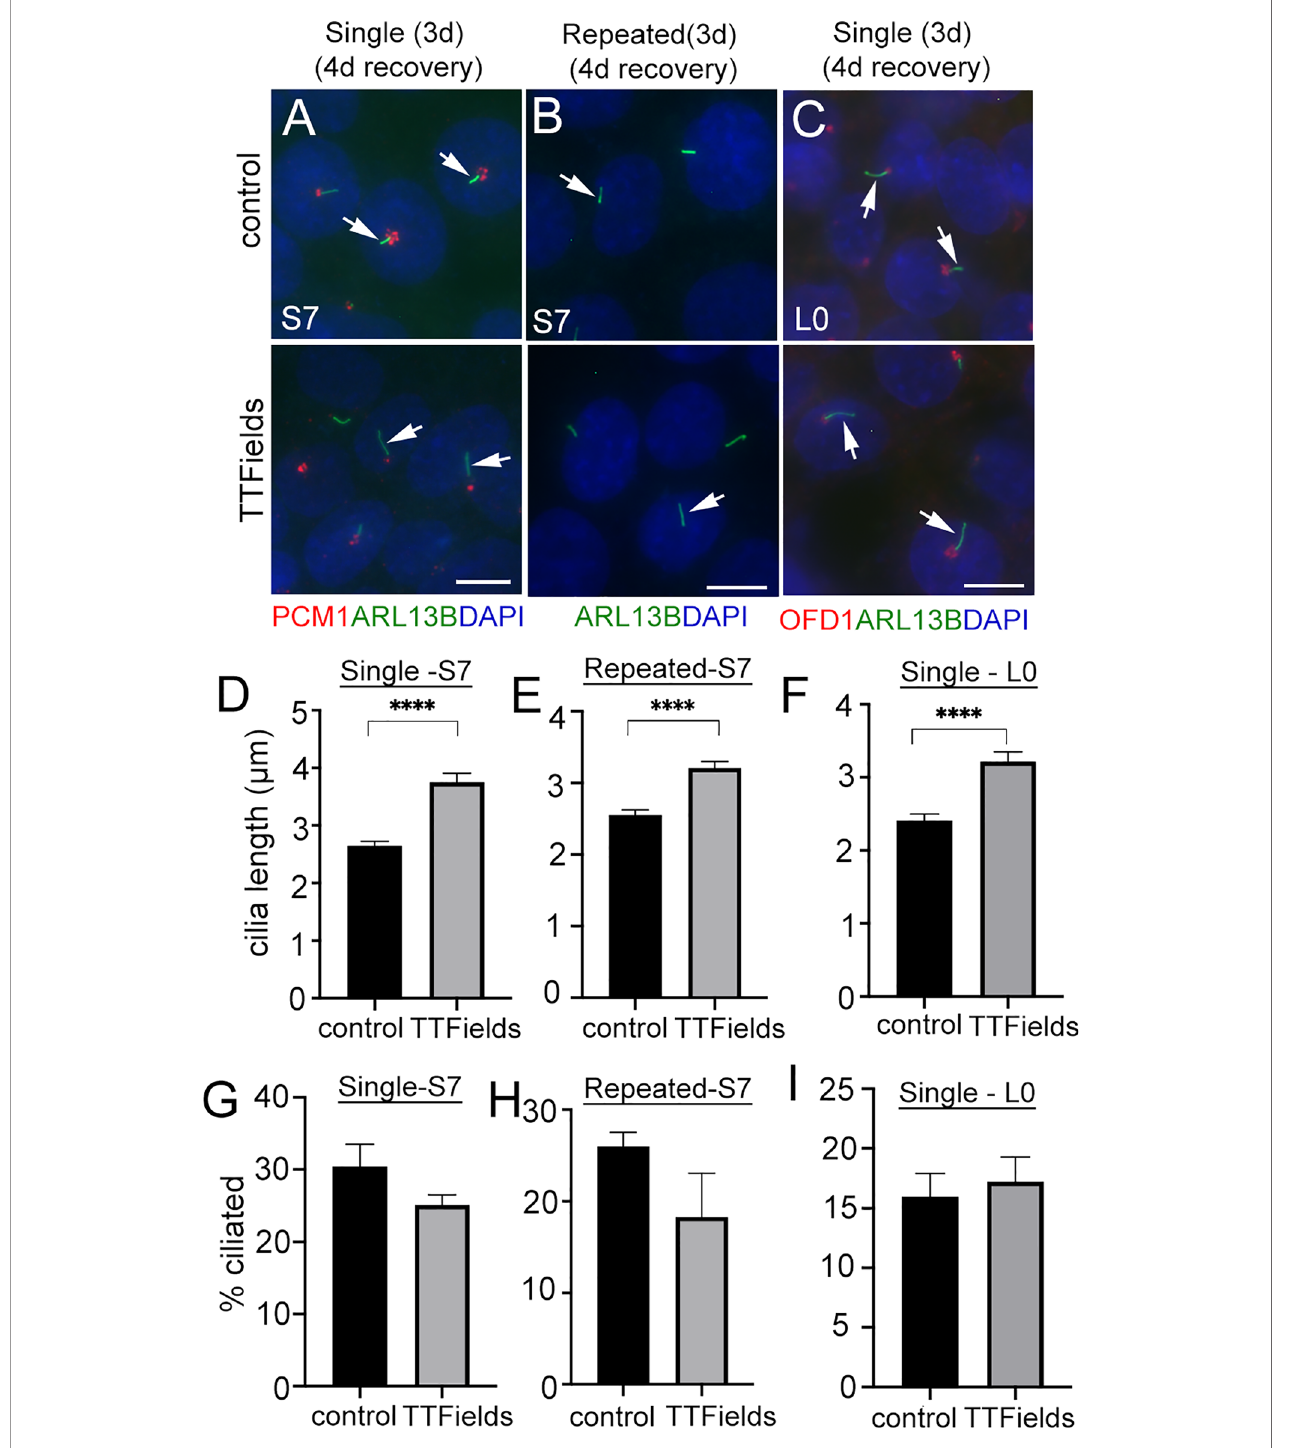
FIGURE 2 | Similar frequencies of elongated glioma cilia after halting TTFields treatment. (A, B) S7 and (C) L0 cells without (control) or with a single or repeated exposure to 3 days (3d) of TTFields treatment then dissociated onto coverslips for 4 days. Fixed cells were immunostained for ARL13B (green), PCM1, or OFD1 (red) with nuclei labeled with DAPI (blue). Control and TTFields-treated cells showed ARL13B + cilia (arrows) extending from the PCM1 + or OFD1 + puncta which concentrates around basal bodies. Scale bar = 10 µm. Mean lengths (µm) of (D, E) S7 and (F) L0 ARL13B + cilia after 4 days recovery from a single or repeated exposure to TTFields. Percent of ciliated cells in (G, H) S7 and (I) L0 after 4 days recovery from a single or repeated exposure to TTFields. **** p < 0.0001